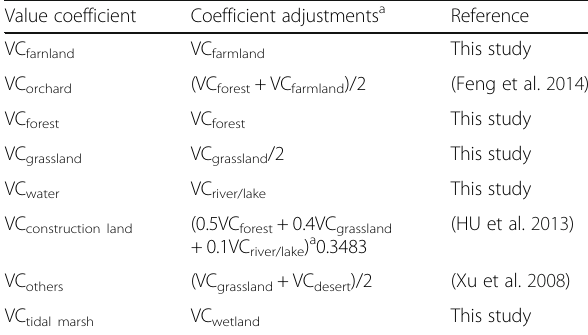
Table 4 Adjusted ecosystem service value coefficient